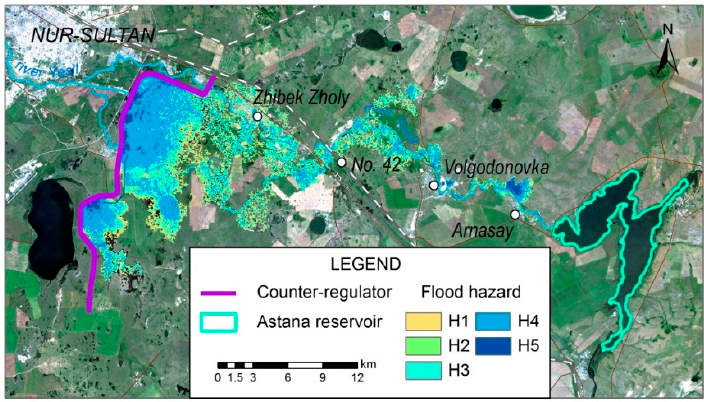
Figure 8. Hazard map (Classification 1) produced from the 20-year return period flow hydrograph.